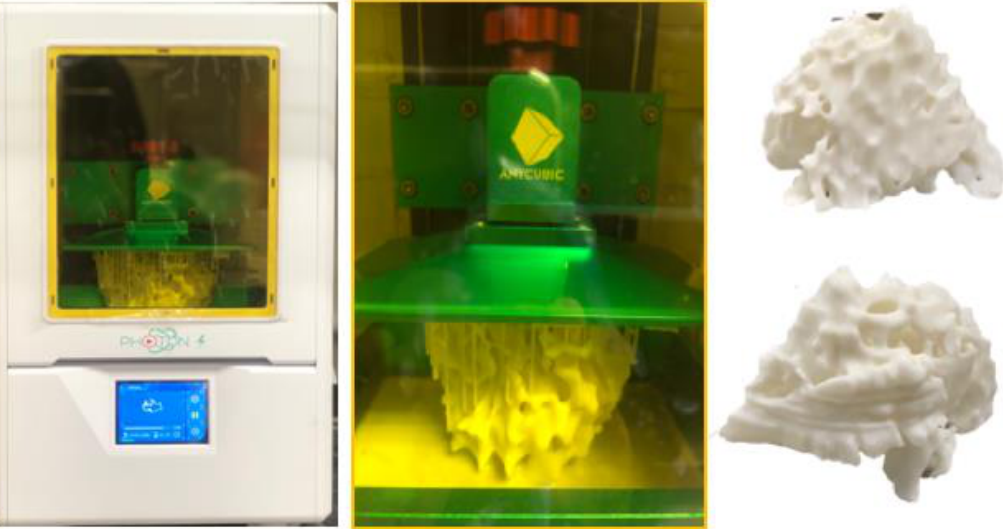
Figure 15. Fabrication of the hollow fibroglandular models using the Anycubic Photon S high-resolution 3D digital light processing printer. The thickness of the wall is 2.0 mm. Reprinted with permission from Sindi et al. [66].